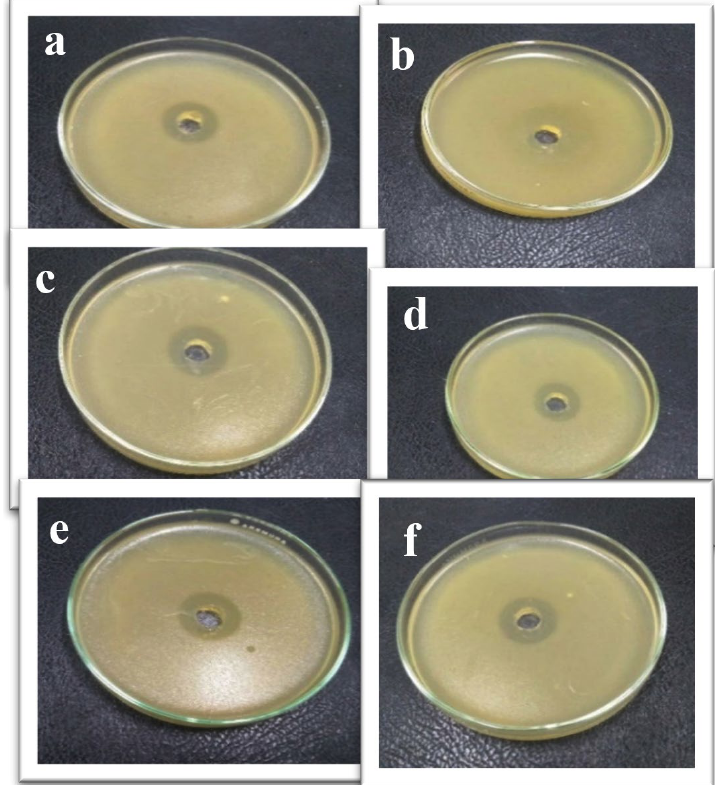
Fig. 10. Inhibition zones produced against tested bacterial isolates (a) K. pneumoniae, (b) E. coli, (c) A. baumannii, (d) P. aeruginosa, (e) S. aureus and (f) S. haemolyticus using green synthesized zinc oxide